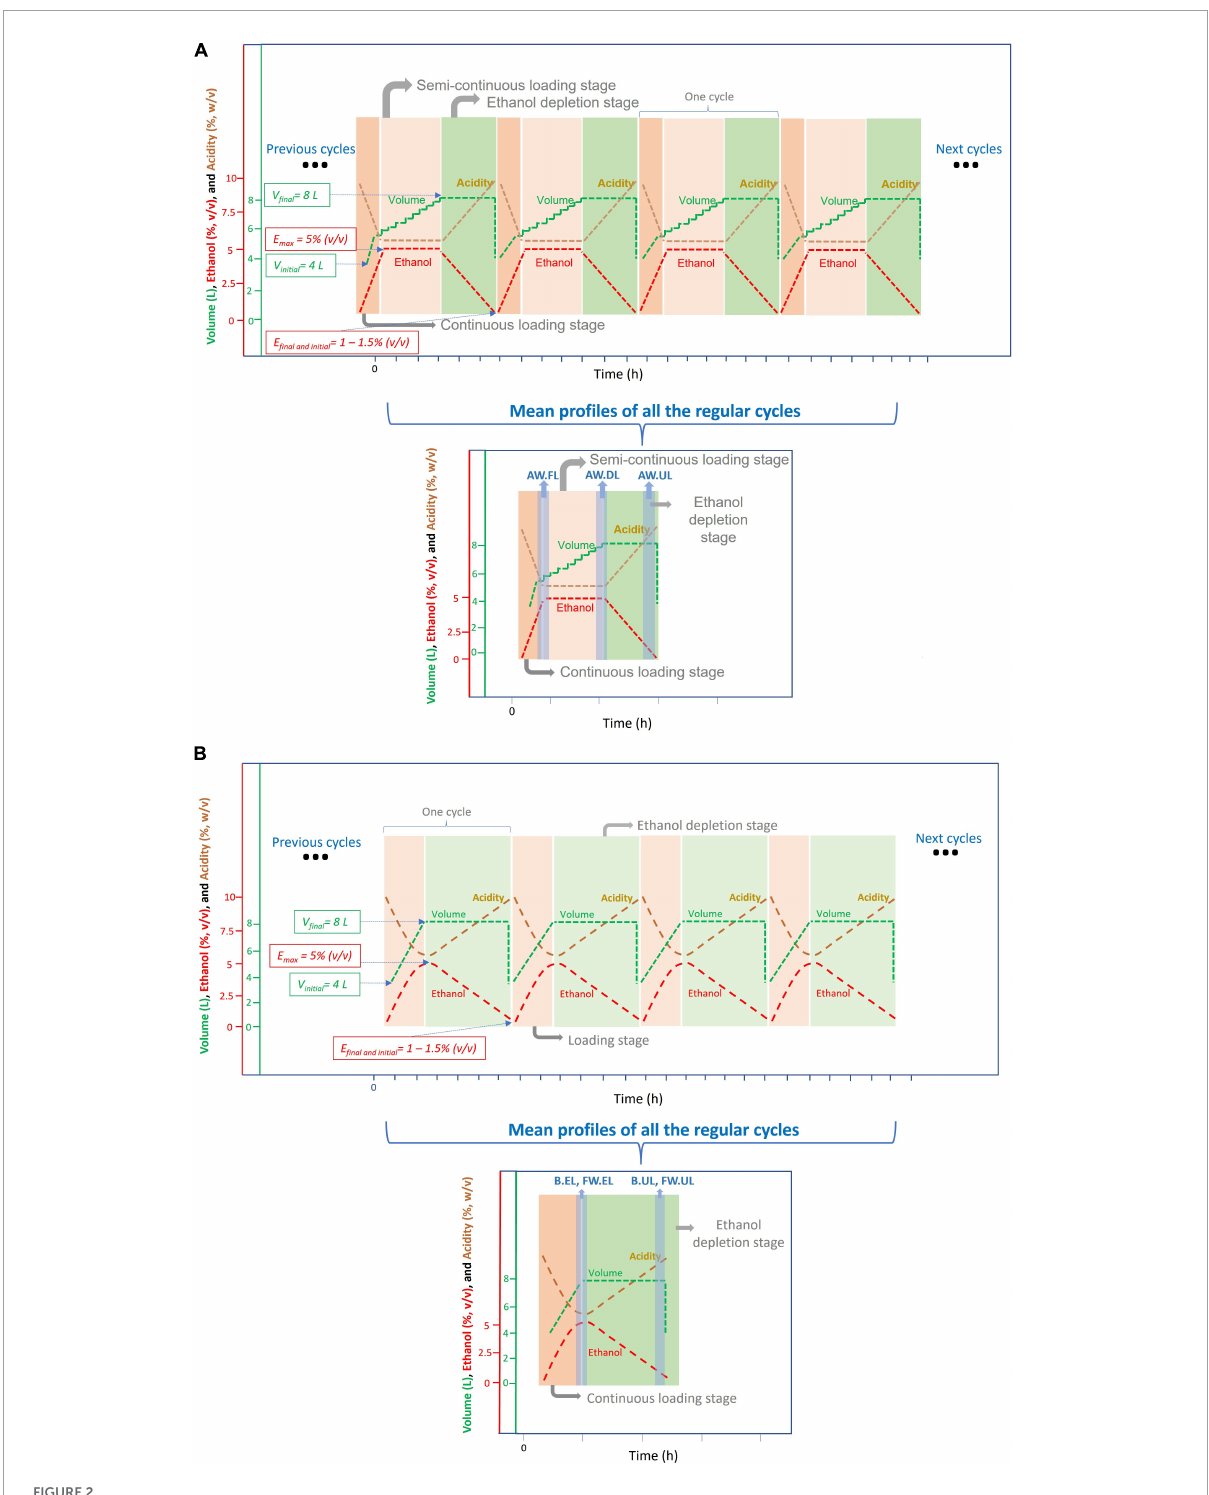
FIGURE2 Scheme representing the operational mode used for the acetification of the different substrates; the experimental data regarding the cycle times for each acetification profile can be found in Román-Camacho et al. (2020) (for AW) and Román-Camacho et al. (2022) (for FW and B). (A) Submerged culture for alcohol wine vinegar (AW) production working in a semi-continuous mode. Each cycle of acetification starts by loading the tank to its working volume (8 L) without exceeding a preset ethanol concentration [5% (v/v)]. Because of a lower ethanol consumption rate in this profile, the preset ethanol concentration [5% (v/v)] is first reached (AW.FL), and therefore, an additional discontinuous loading stage (AW.DL) is necessary to reach the final working volume (8 L). When ethanol concentration is depleted to 1.0–1.5% (v/v), 50% of